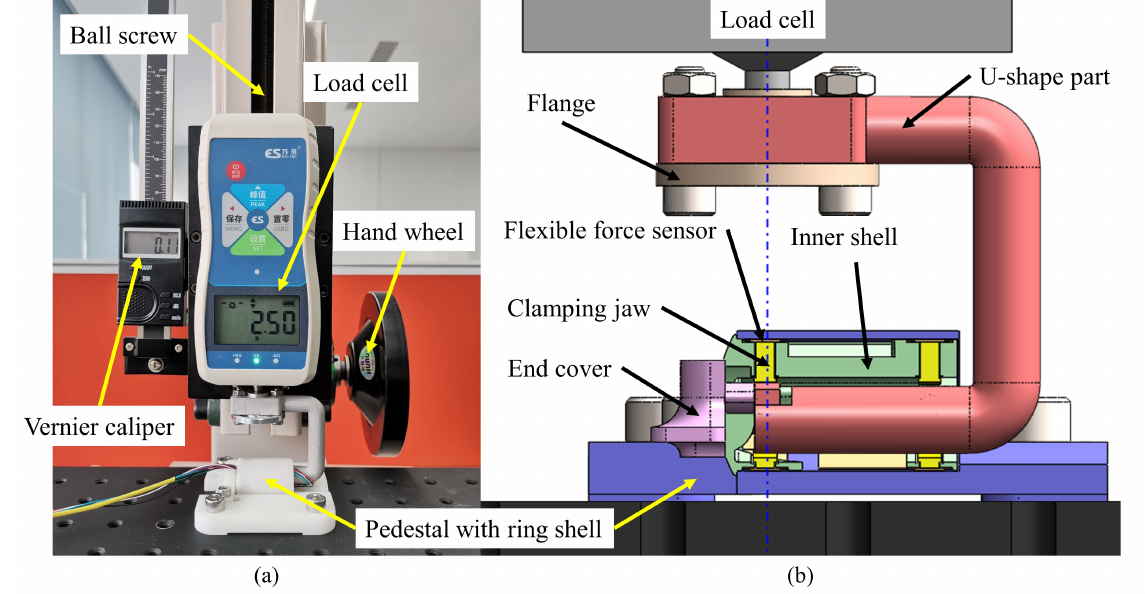
Figure 4. Sensor calibration. ( a ): The equipment for sensor calibration. ( b ): 3D model of the equipment.